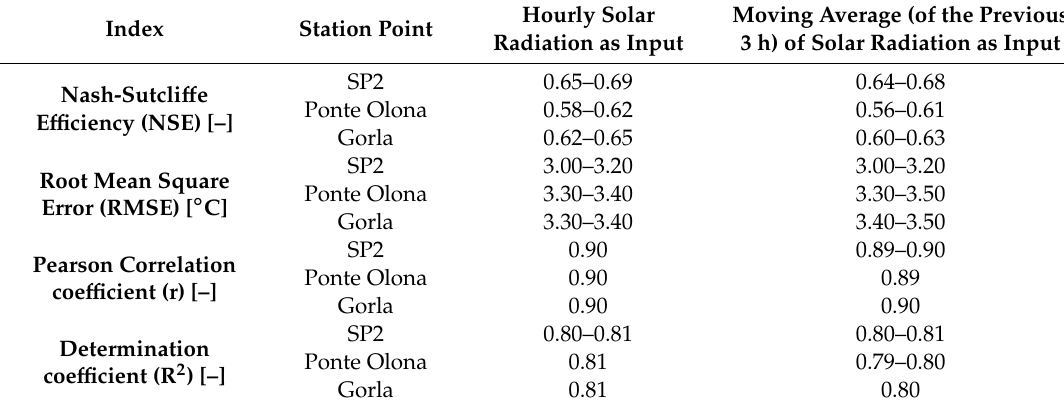
Table 8. Statistical indexes during cloudy days between observed and forecasted LST values by the MEC algorithm using the hourly solar radiation and the 3 h-moving average as